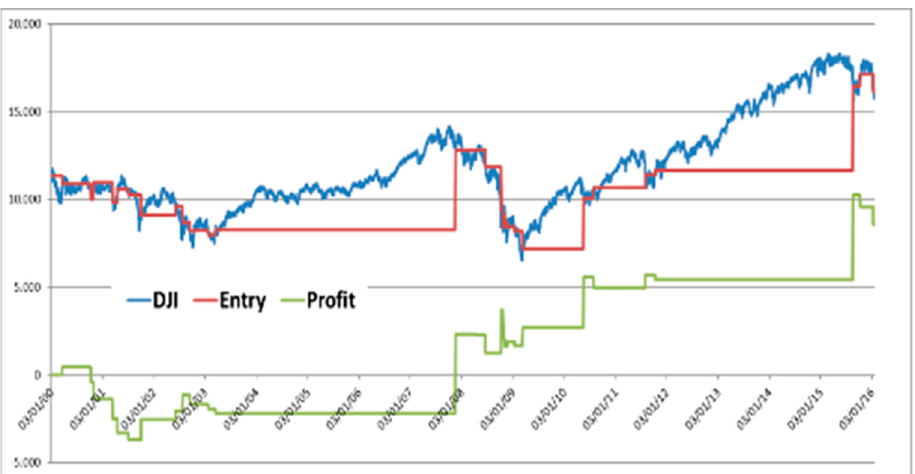
Figure 9. Default Output Limit Exit Strategy. Source: Authors’ processing is based on data available on http://stooq.com/ (accessed on 20.07.2017).